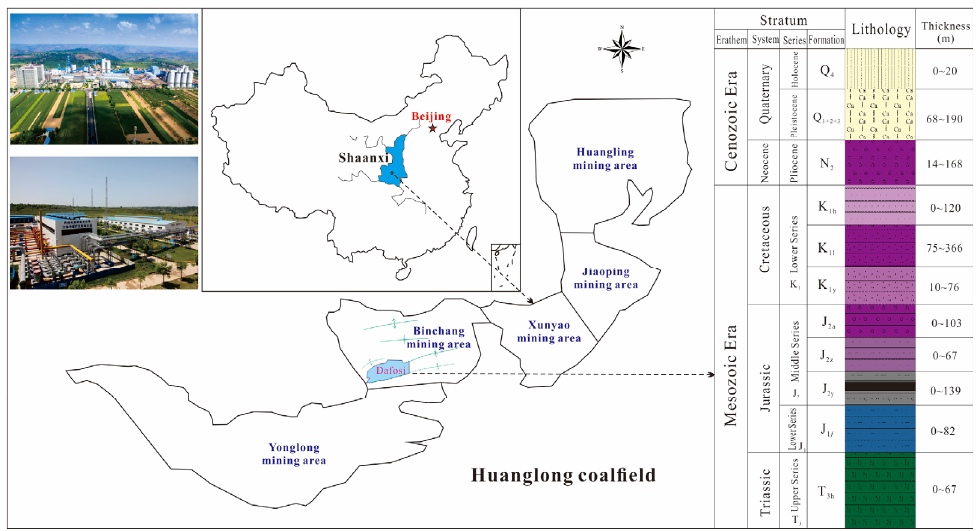
Figure 1. The location and stratum of Binchang mining area.